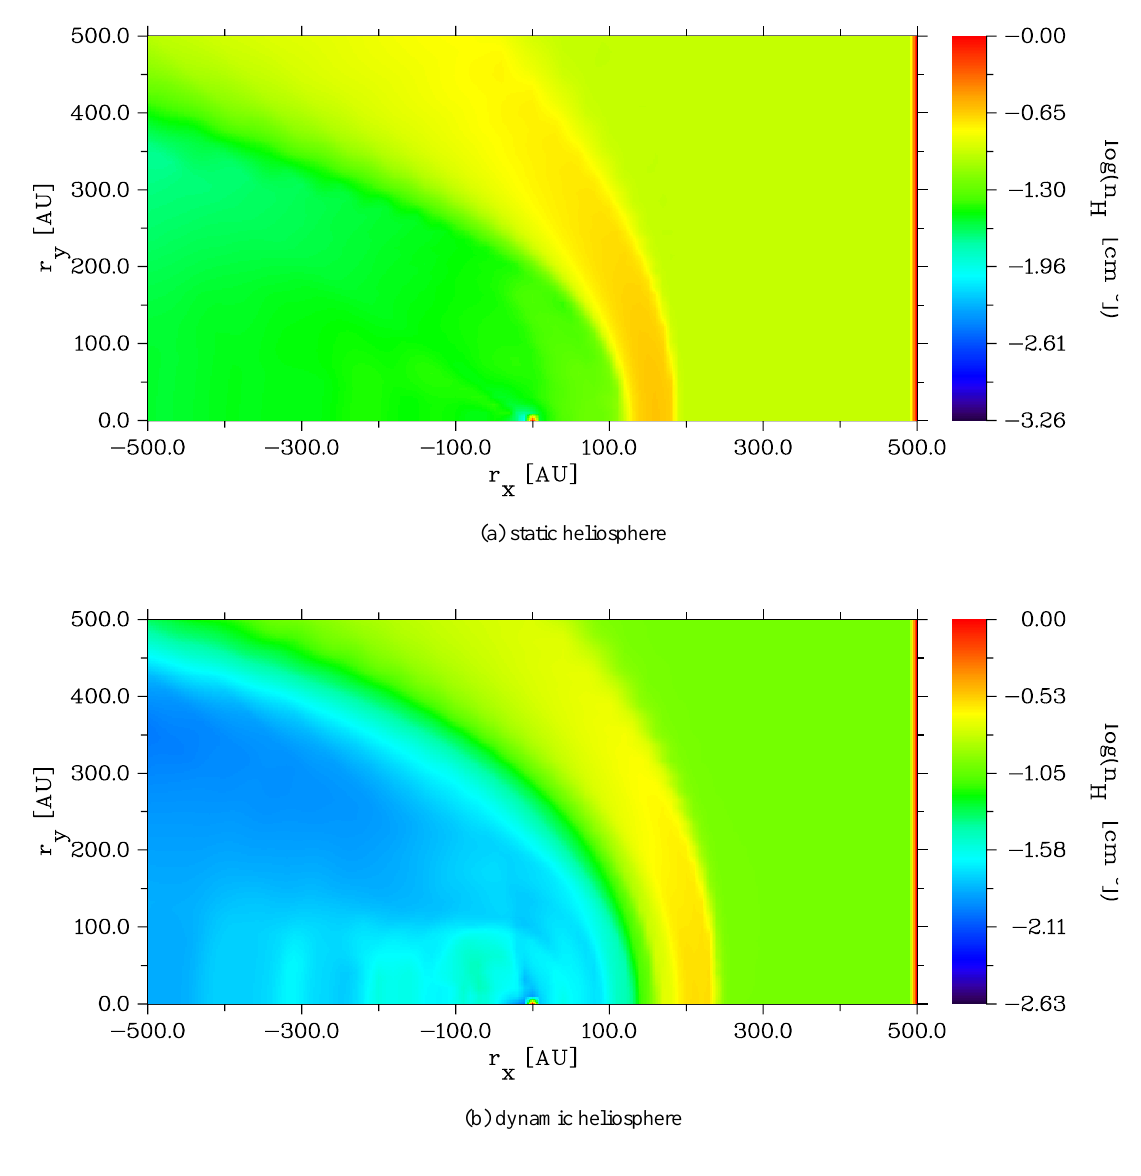
Fig. 3. Same as in Fig. 1 for the hydrogen distribution. To enhance the effects the solar wind speed variations reach from 300km/s to 800km/s for a pure sinusoidal law. Moreover, a logarithmic scale is chosen.